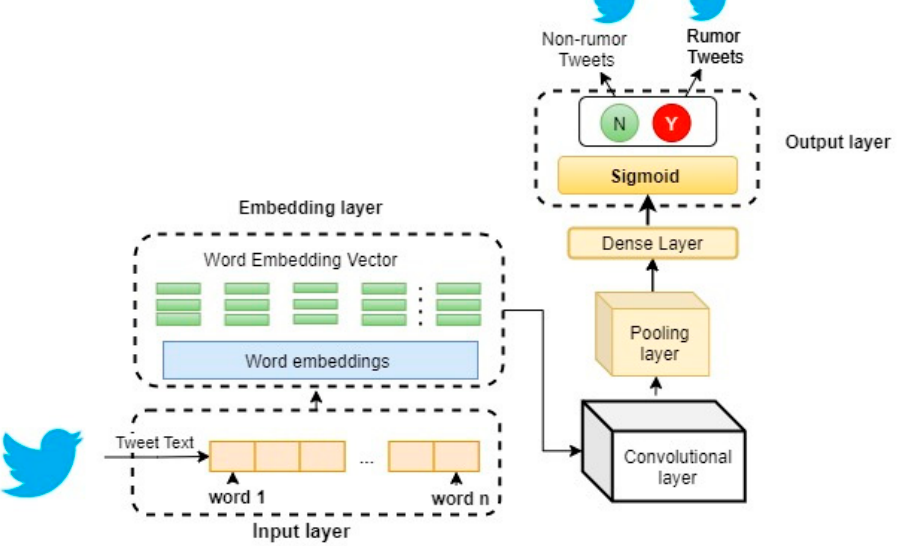
Figure 2. Illustration of a typical CNN architecture for rumor detection